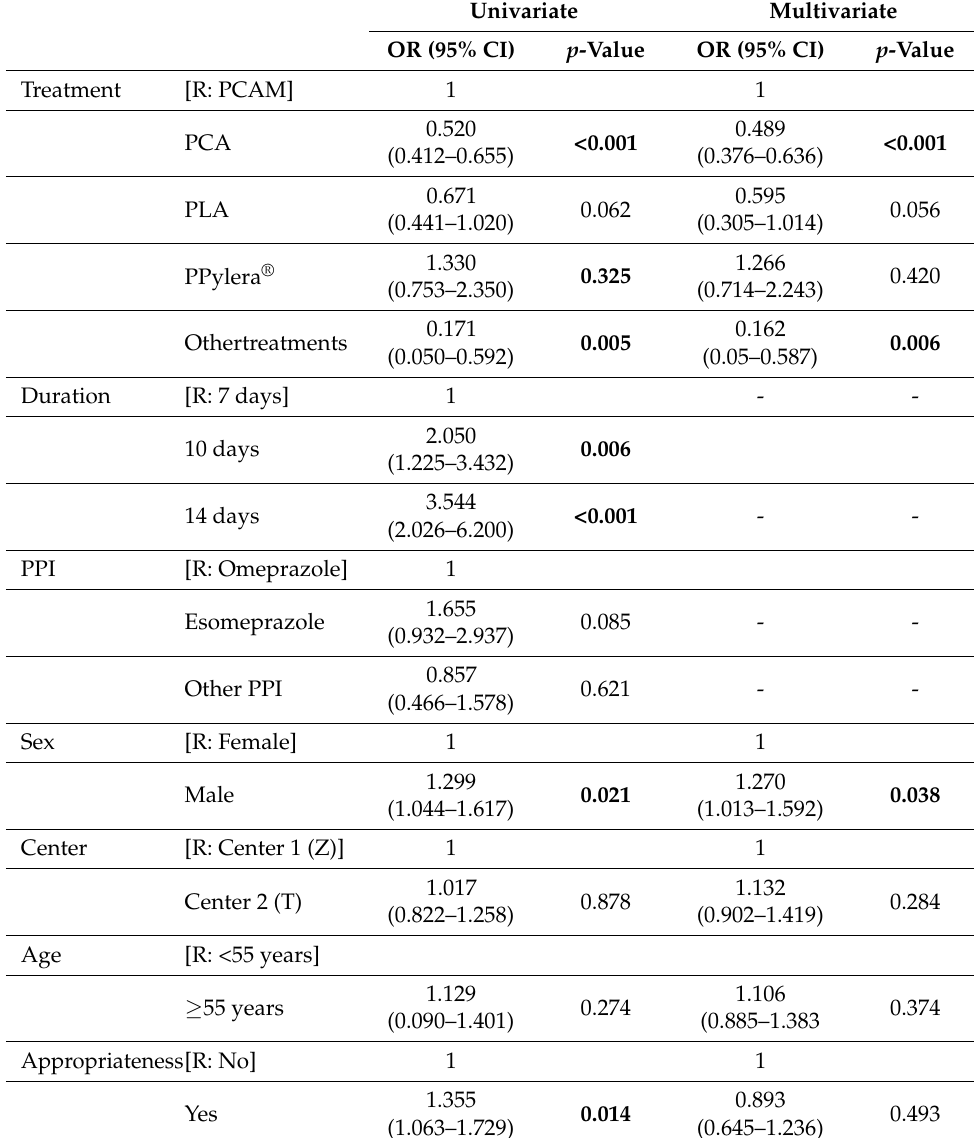
Table 3. Analysis of association with global efficacy by univariate and multivariate binary logistic regression. Intention To Treat (ITT) analysis of 1644 first-line treatments in non-penicillin-allergic